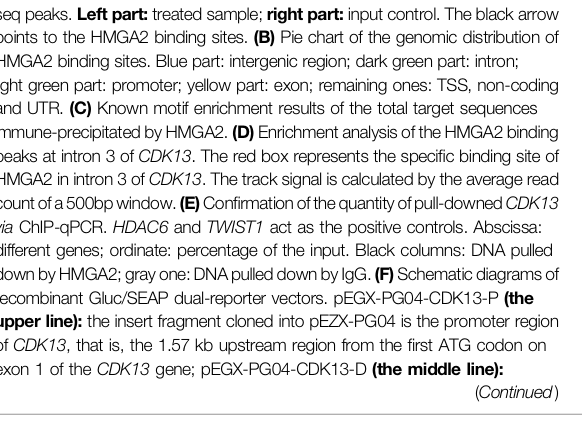
FIGURE 4 | CDK13 is the direct target of HMGA2. (A) Heat map of ChIP- seq peaks. Left part: treated sample; right part: input control. The black arrow points to the HMGA2 binding sites. (B) Pie chart of the genomic distribution of HMGA2 binding sites. Blue part: intergenic region; dark green part: intron; light green part: promoter; yellow part: exon; remaining ones: TSS, non-coding and UTR. (C) Known motif enrichment results of the total target sequences immune-precipitatedbyHMGA2. (D) EnrichmentanalysisoftheHMGA2binding peaks at intron 3 of CDK13 . The red box represents the speci fi c binding site of HMGA2 in intron 3 of CDK13 . The track signal is calculated by the average read countofa500bpwindow. (E) Con fi rmationofthequantityofpull-downed CDK13 via ChIP-qPCR. HDAC6 and TWIST1 act as the positive controls. Abscissa: different genes; ordinate: percentage of the input. Black columns: DNA pulled downbyHMGA2;grayone:DNApulleddownbyIgG. (F) Schematicdiagramsof recombinant Gluc/SEAP dual-reporter vectors. pEGX-PG04-CDK13-P (the upper line): the insert fragment cloned into pEZX-PG04 is the promoter region of CDK13 , that is, the 1.57 kb upstream region from the fi rst ATG codon on exon 1 of the CDK13 gene; pEGX-PG04-CDK13-D (the middle line): ( Continued )